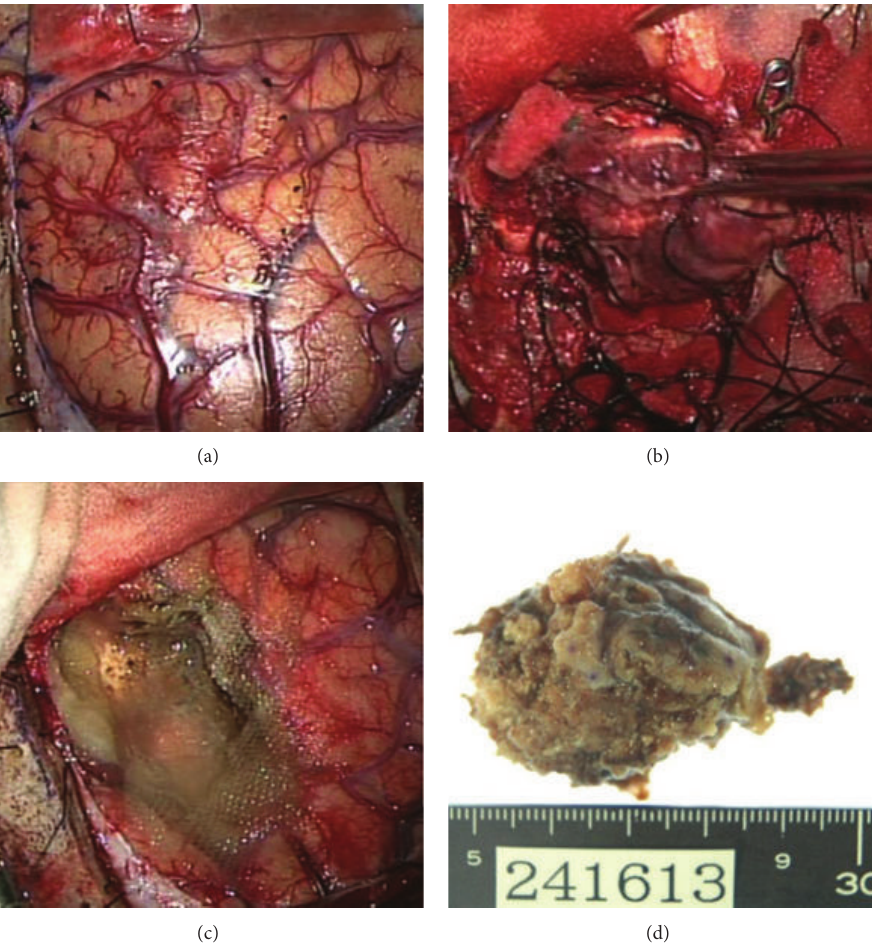
Figure 3: (a) The brain surface was yellow and had abnormal neovascularization. (b) The tumor bled easily and had some cysts and areas of old hemorrhage. (c) The tumor was resected totally in a procedure similar to gyrectomy. 5-ALA was used to assess resection. (d) Exenterated specimen was yellowish and 5 cm in